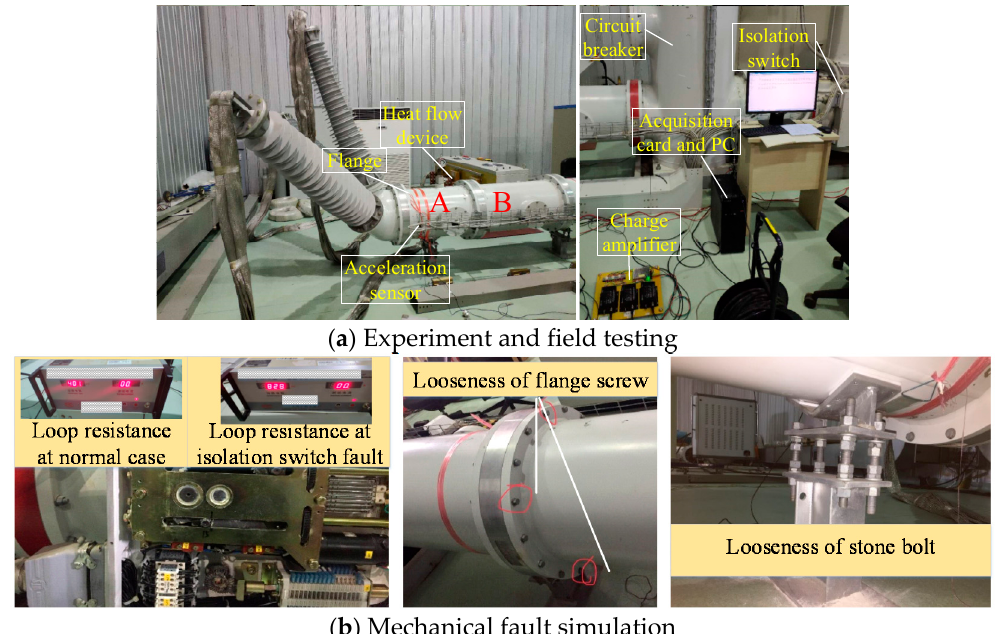
Figure 1. Experiment and mechanical fault simulation.